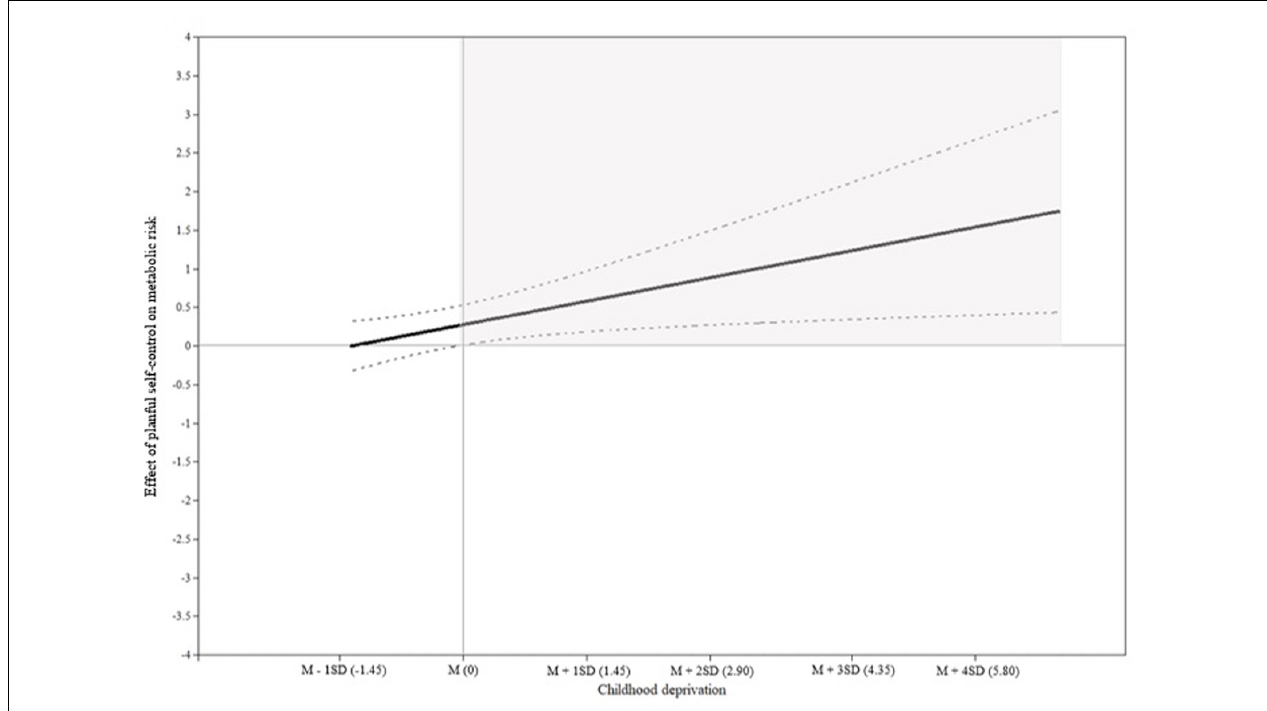
FIGURE 3 | Johnson-Neyman plot. The gray shaded areas indicated the region of significance. The x-axis indicates the score of childhood deprivation and the y-axis represents the effects of planful self-control on metabolic risk. The black solid line represents the effects of planful self-control on metabolic risk corresponding to the values of childhood deprivation. Dashed lines show the 95% confidence